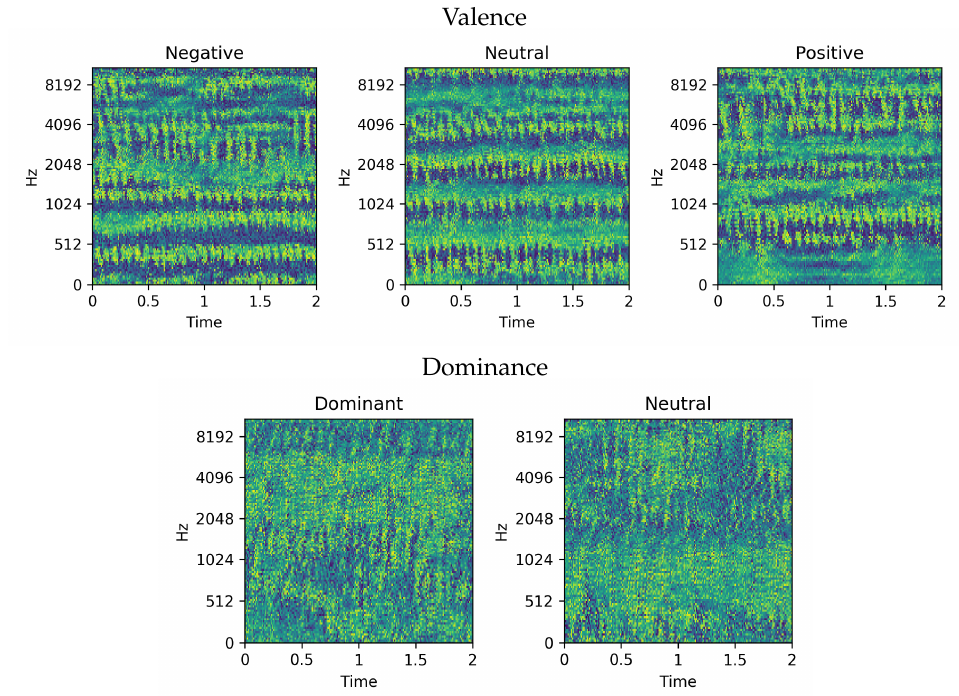
Figure 5. Extraction of the suitable spectrogram that maximises the classification output for each class using the DeepDream